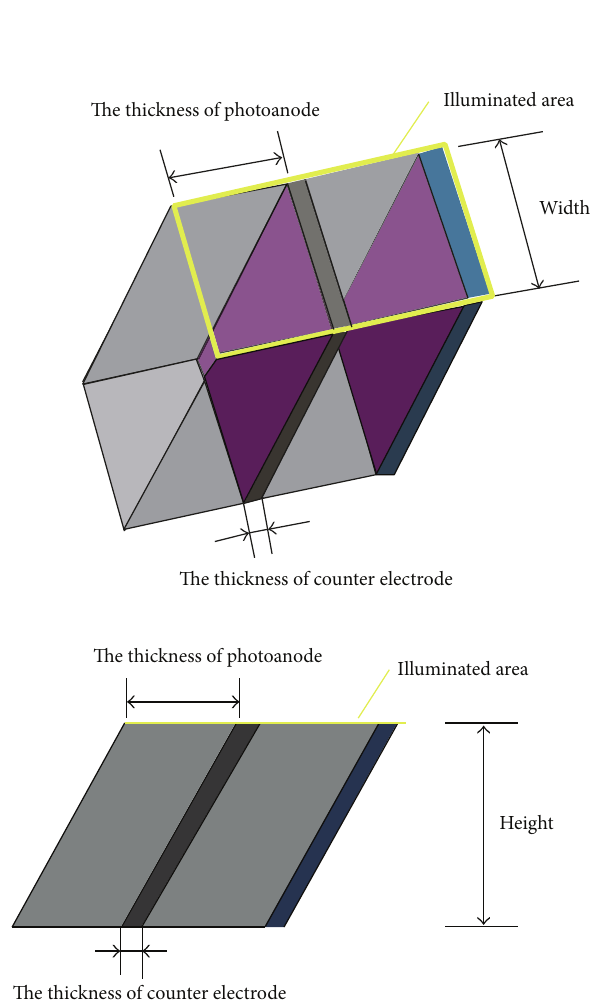
Figure 4: Schematic diagram of different parts of 3D structured DSSC.